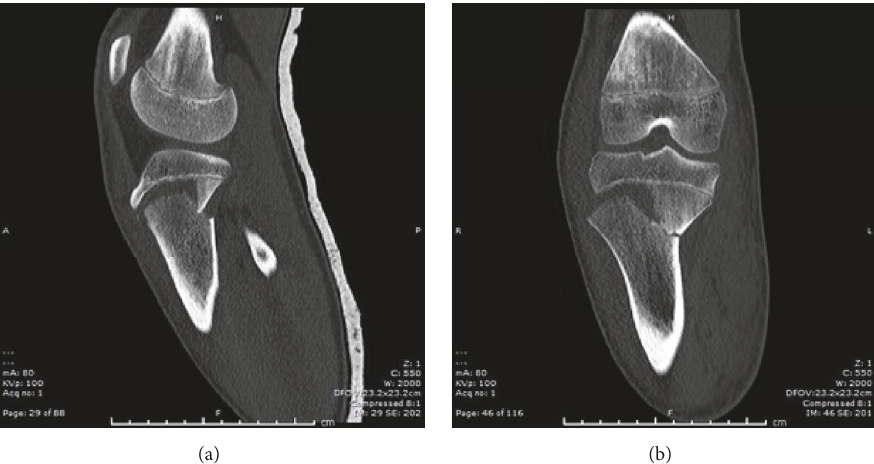
Figure 4: Sagittal (a) and coronal (b) slices of noncontrast CT scan of patient’s right knee demonstrating grade IV proximal tibial avulsion fracture.